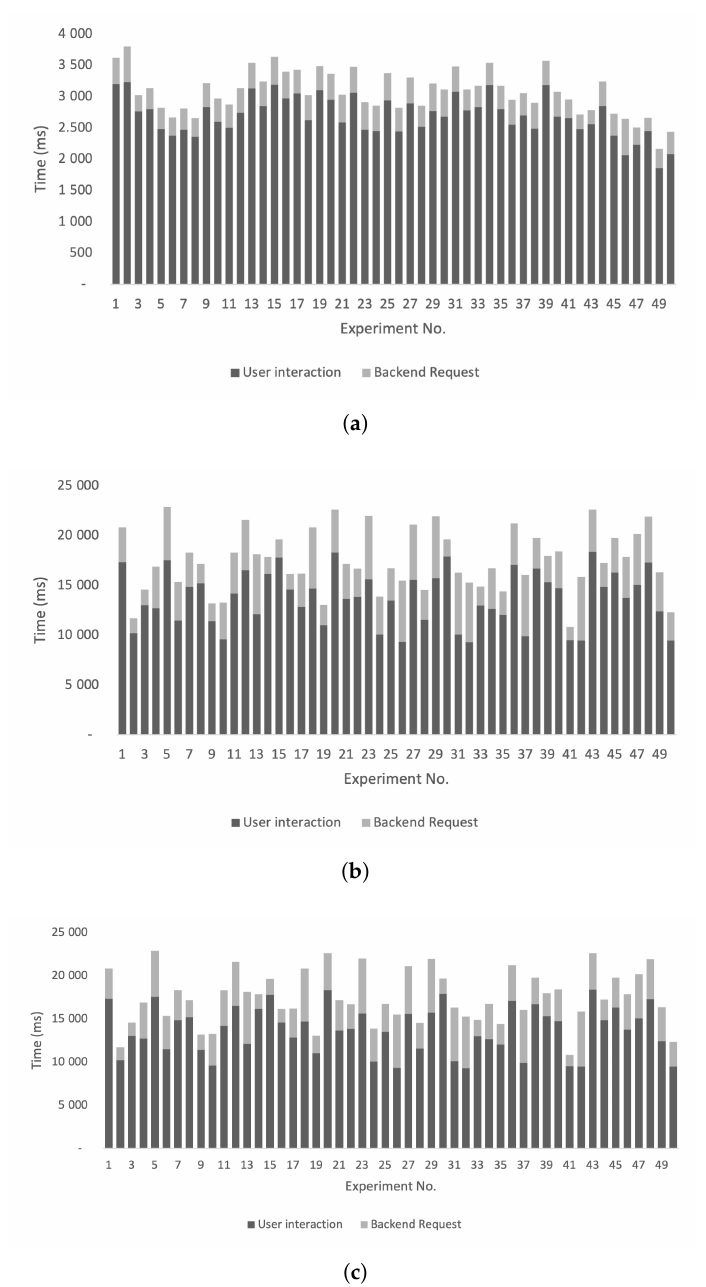
Figure 6. Time spent on logging in. ( a ) Wallet login; ( b ) Mobile wallet login; ( c ) SMS